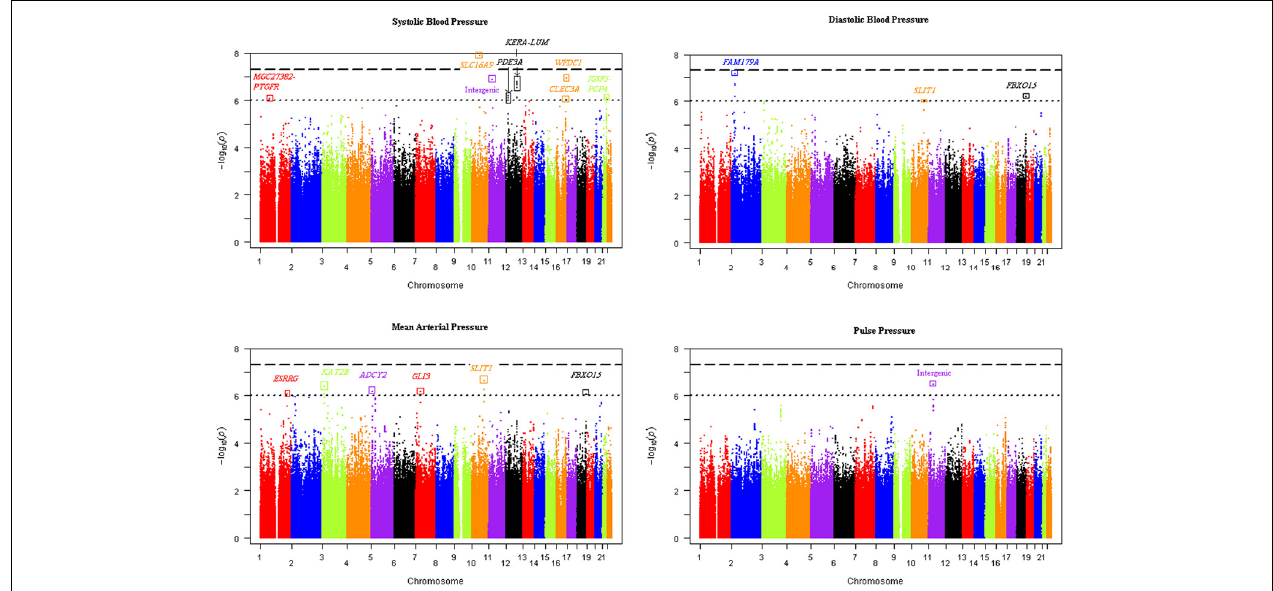
FIGURE 1 | Manhattan plots of the joint 2 degree-of-freedom test of the SNP main effect and SNP-drinks per week interaction for each blood pressure trait. The -log( p -value) of the joint 2df test of